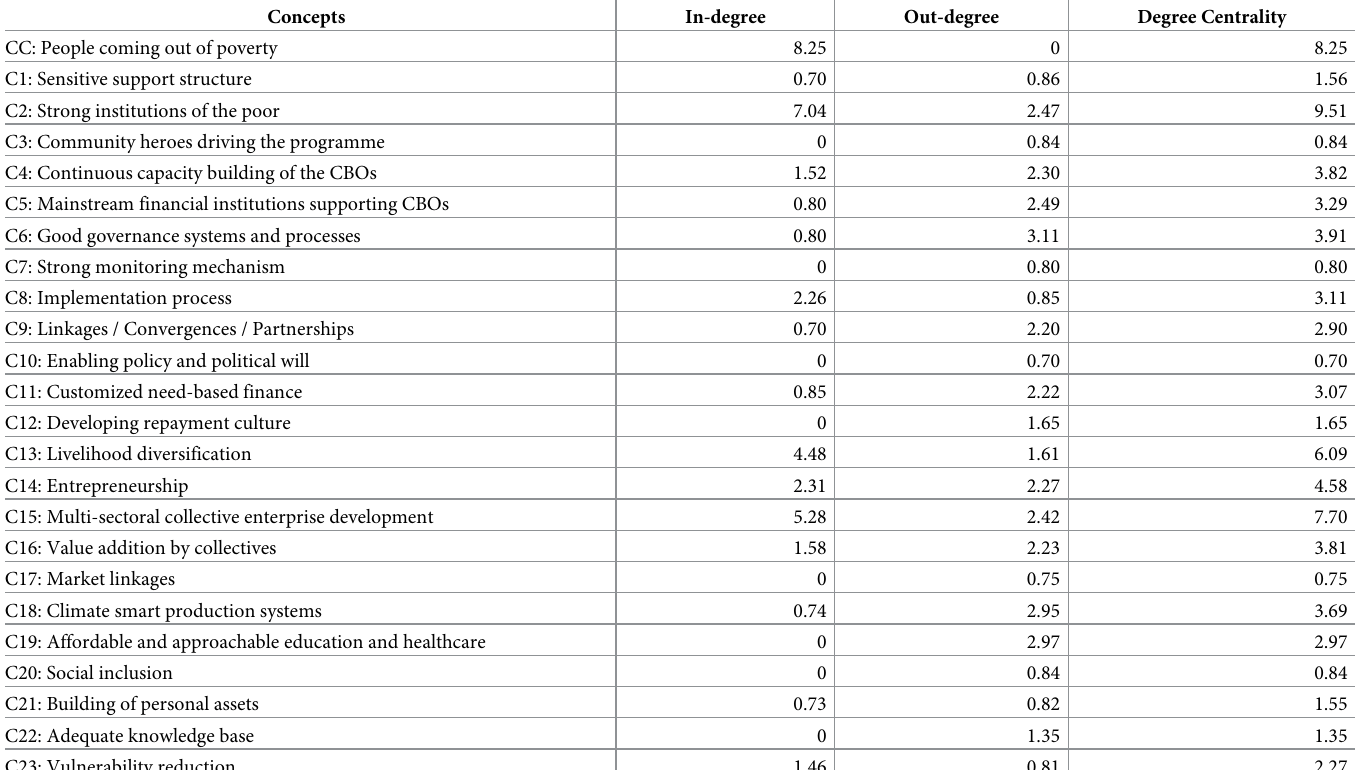
Table 1. The structural analysis of the FCM